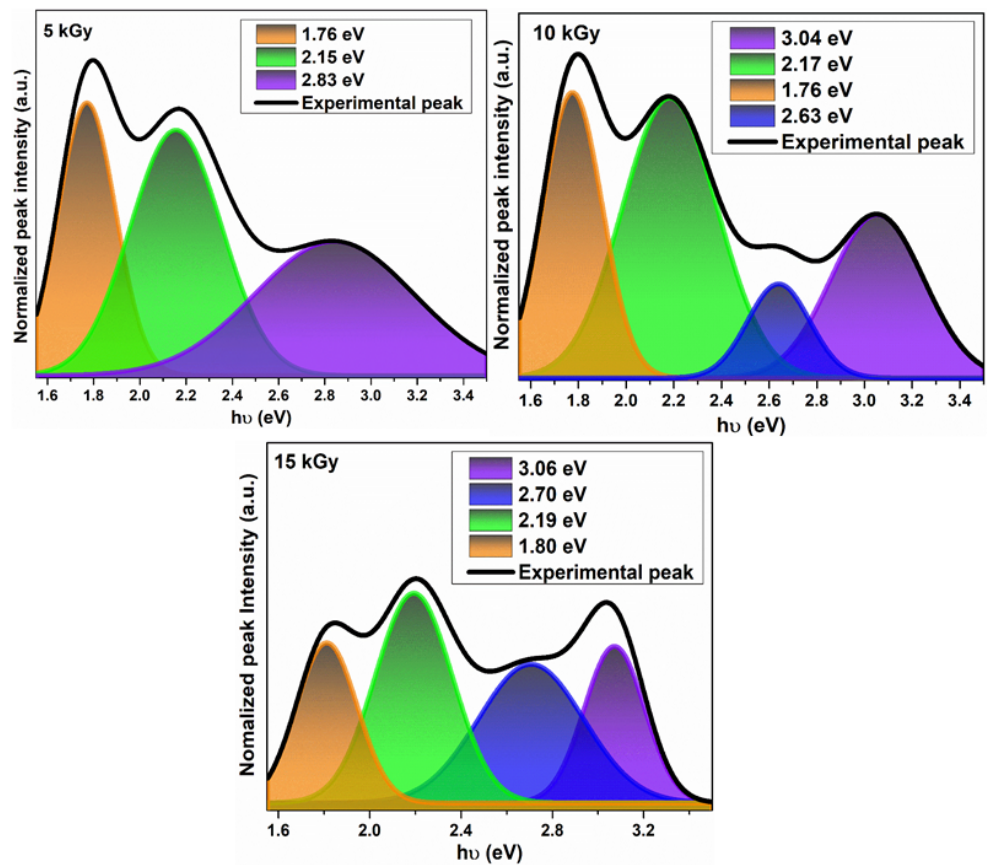
Figure 4. RTPL spectra of irradiated IZO thin films deconvoluted by Gaussian function. The emission around 2.96 eV–2.88 eV represents the near band edge emission corre- sponding to the exciton–exciton collision, resulting in free exciton recombination [36,37]. The blue and orange emissions correspond to oxygen interstitial defects. The green emis- sion represents the oxygen vacancy defects, which is one among the factors responsible for gas sensing [34–37]. The FWHM of the green emissions are 0.42, 0.45, and 0.39 for 5, 10, and 15 kGy irradiated IZO films, respectively. The FWHM is higher for 10 kGy irradiated, supporting the fact that the oxygen vacancies are enhanced in the film after irradiation. The blue emission is absent in IZO film irradiated at 15 kGy and an additional yellow emission at 1.88 eV corresponding to oxygen interstitial is observed [36].